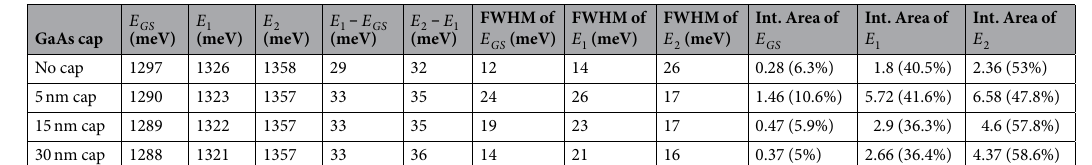
1.46 (10.6%) 5.72 (41.6%) 6.58 (47.8%)